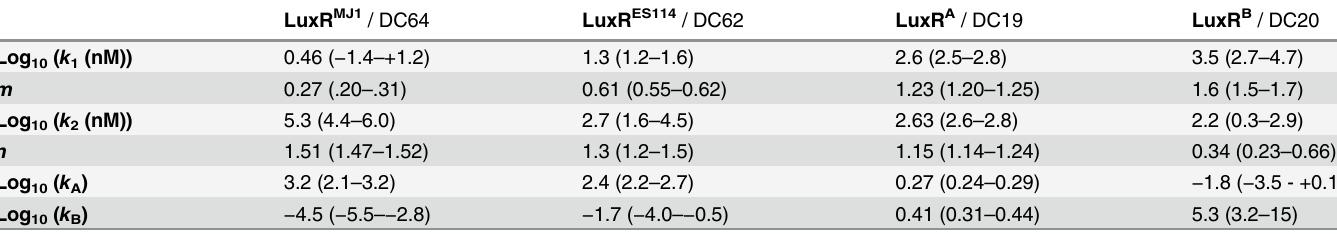
Table 2. Parameter estimates obtained from fit to luminescence (vs. C8-HSL and 3OC6-HSL)